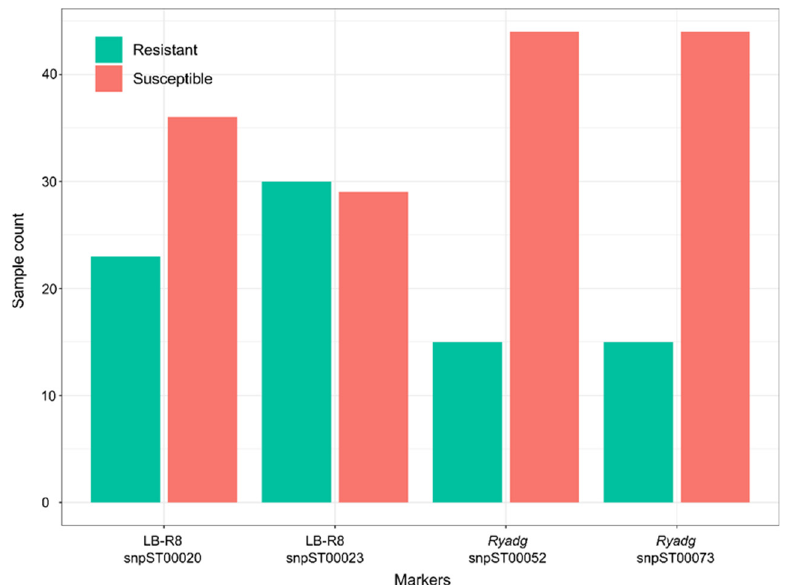
Figure 3. Count of resistant and susceptible samples ( n = 58) in the LBHT population with the late blight and Ryadg KASP markers.